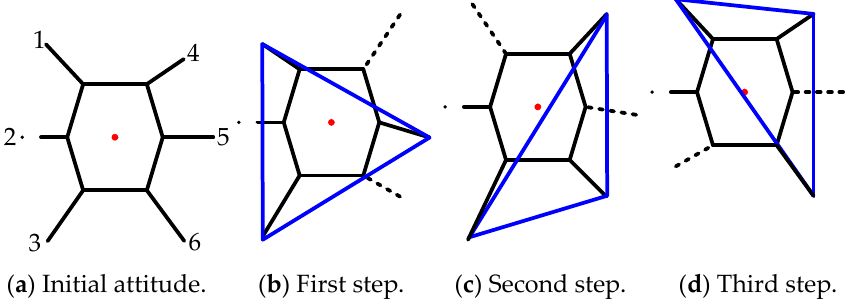
Figure 8. Transfer order of legs in fault tolerant tripod gait in leg 2 fault state.